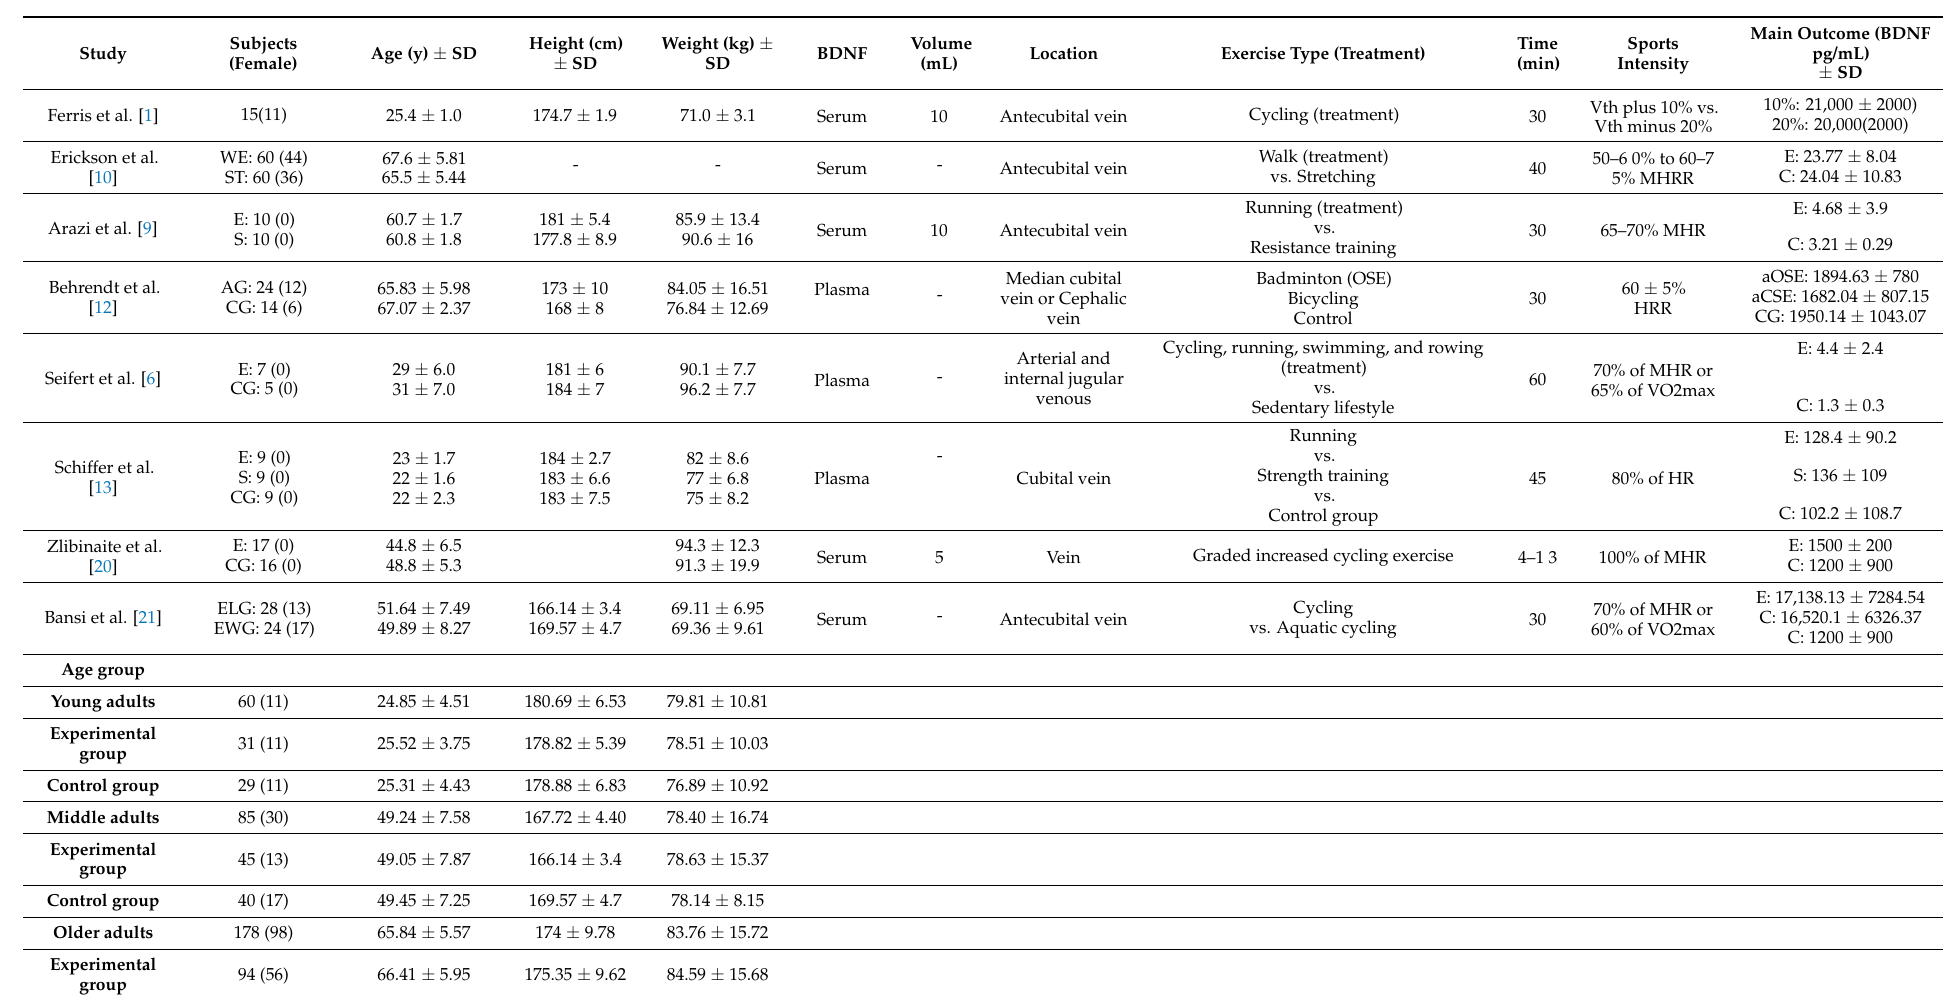
Table 1. Participant and exercise characteristics of included studies (N = 323; n = 170 endurance group; n = 153 control